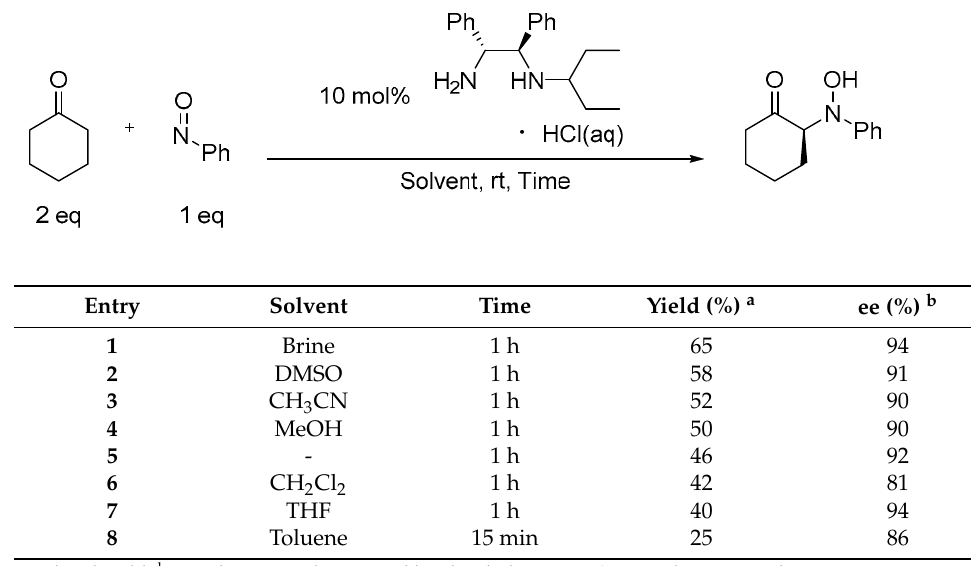
Table 1. Solvent effects on the nitroso aldol reaction.